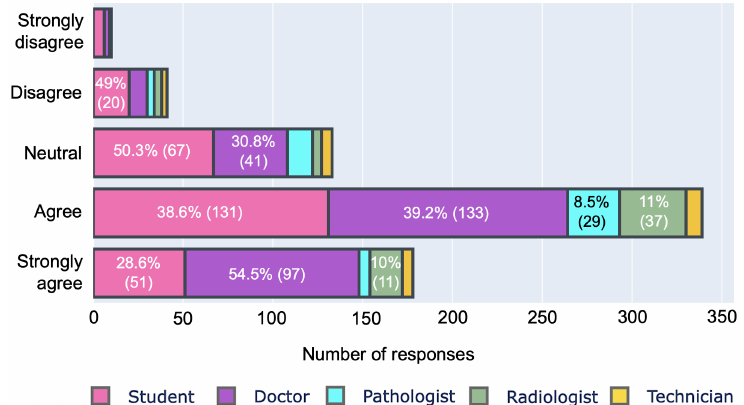
Figure 5. Data privacy and confidentiality risk in digitalization.